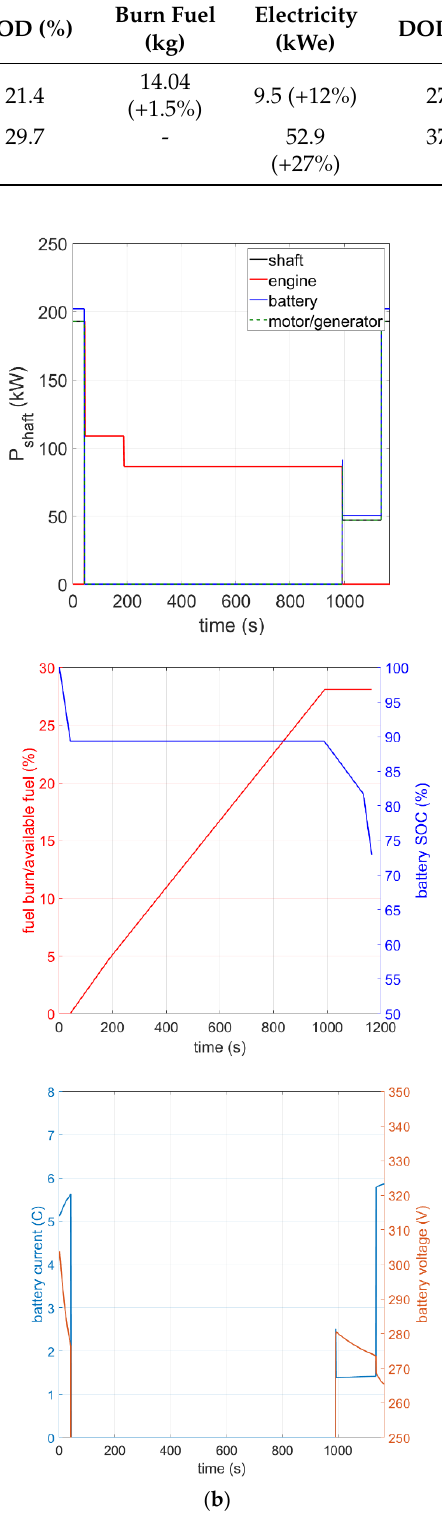
Figure 9. Effect of battery aging on the behavior of the hybrid electric air taxi (the hybrid electric taxi with 2035 technology). ( a ) new battery; ( b ) aged battery.